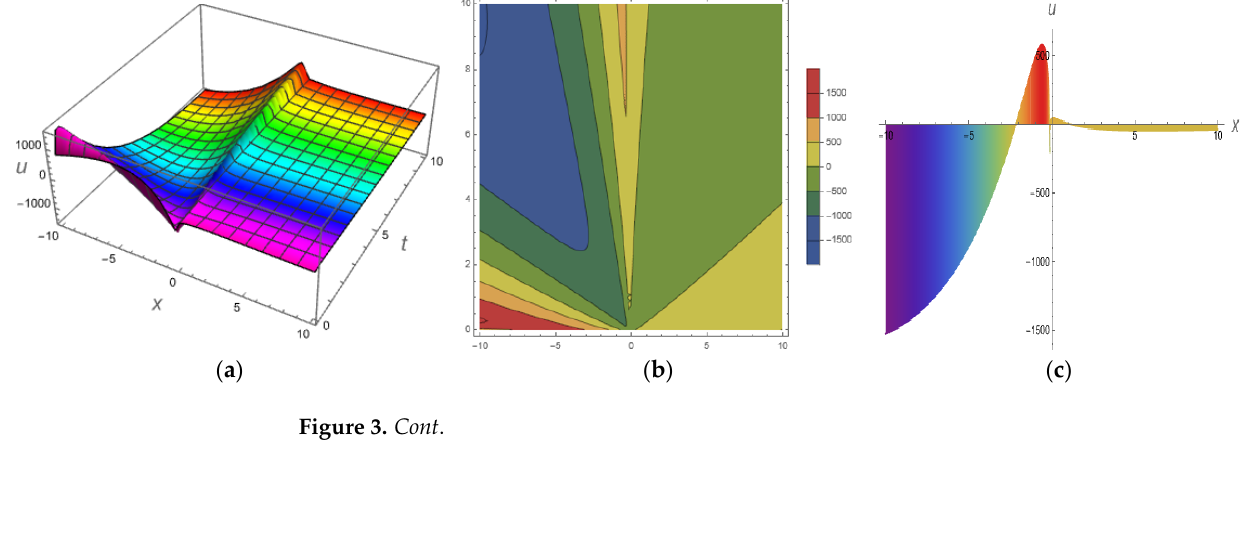
Re( at Re( ( , )) U ( a ) at α α I ν= = = = = = = = = = 0.95. ( c ) 2D visualization at = α ( a ) = 0.99. ( f ) 2D visualization α α = 0.95. ( c ) 2D visualization at = α = 0.99. ( f ) 2D visualization